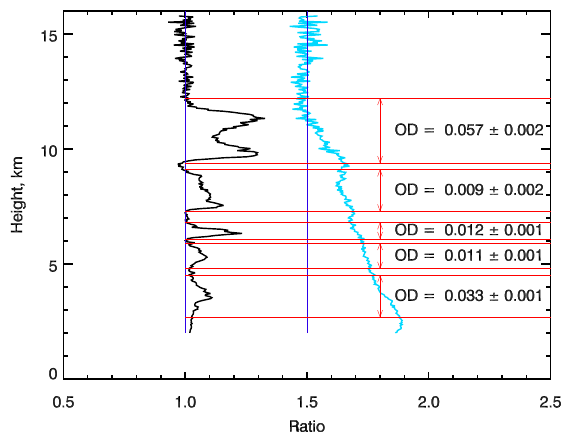
Figure 2. Normalised ratios of elastic to Raman signals (black, nor- malised to 1) and synthetic to Raman molecular signals (blue, nor- malised to 1.5), using Capel Dewi lidar data from the night of 23– 24 May 2016, between 21:49 and 03:09UTC. The Castor Bay ra- diosonde profile for 00:00UTC on 24 May 2016 was used for the molecular profile. Five distinct layers are identified, each by hori- zontal lines at their boundaries. The AOD is also shown for each layer.